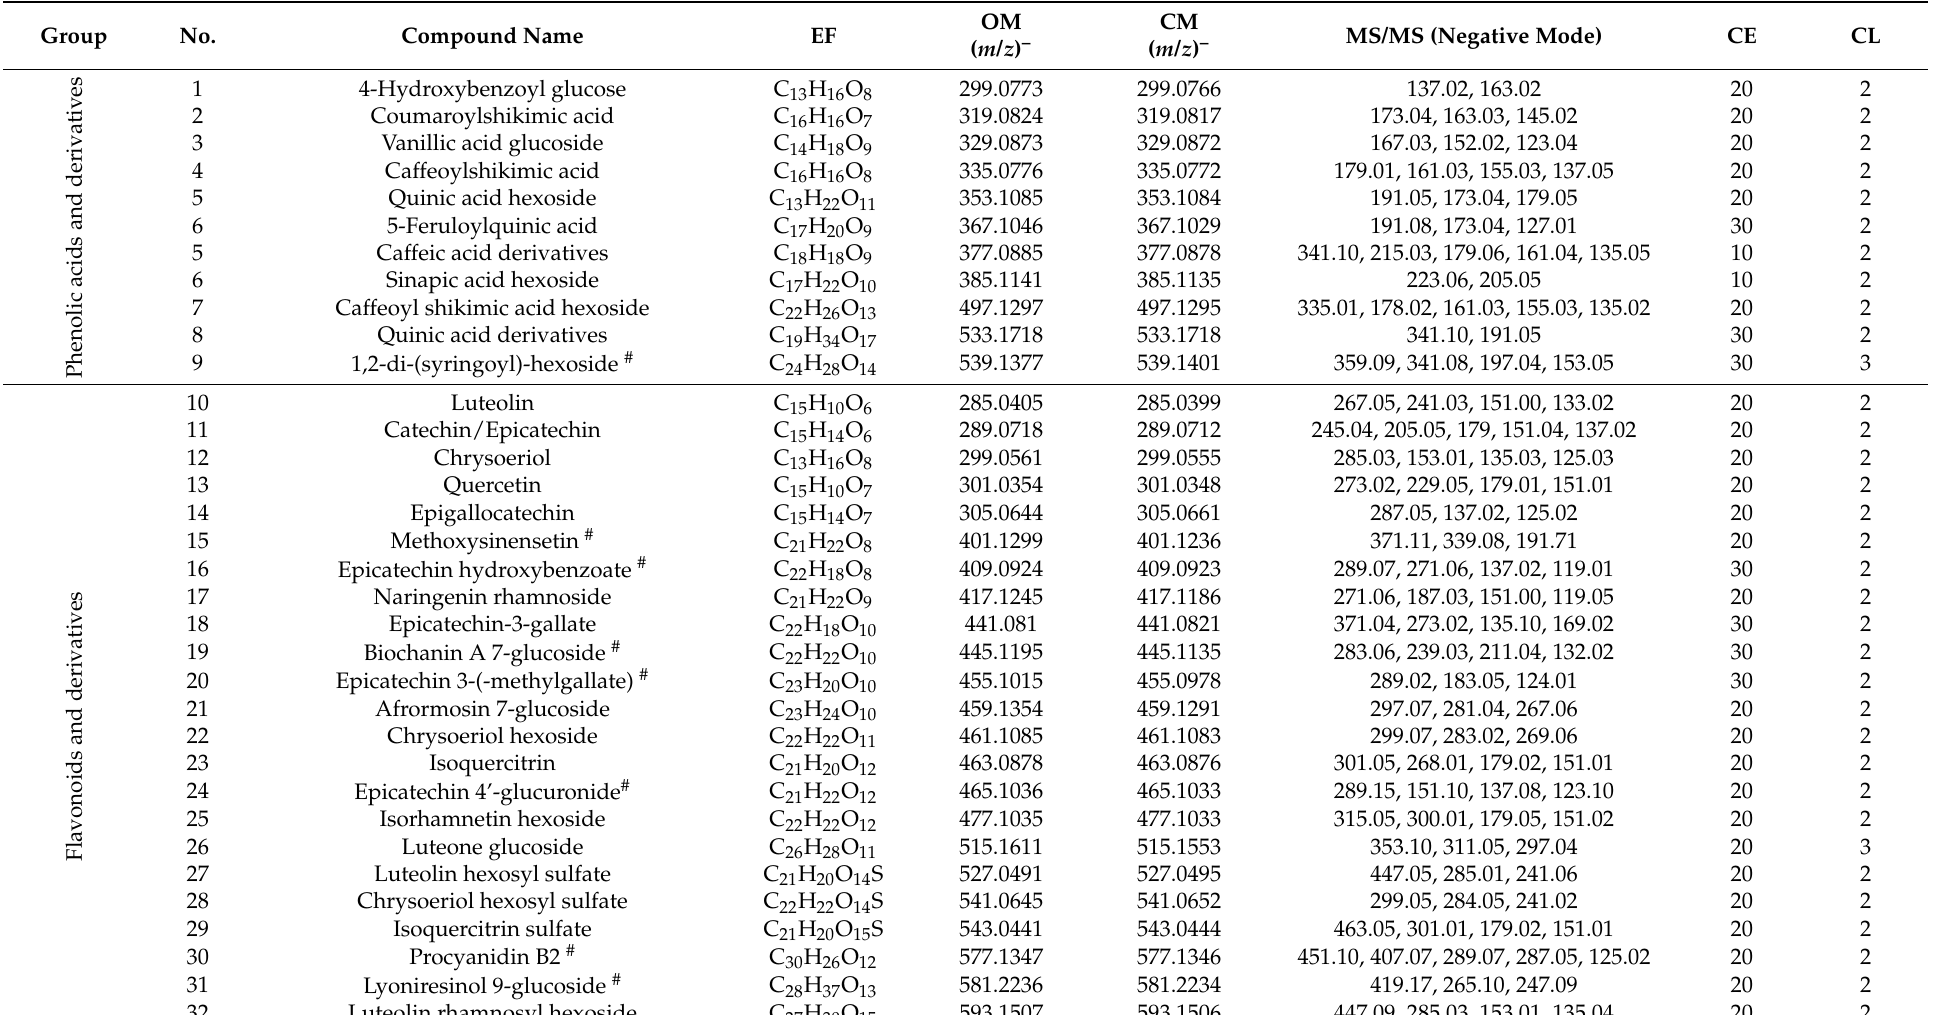
Table 4. List of tentative identified compounds of the optimized extract of URADP by electrospray ionization mass spectrometry